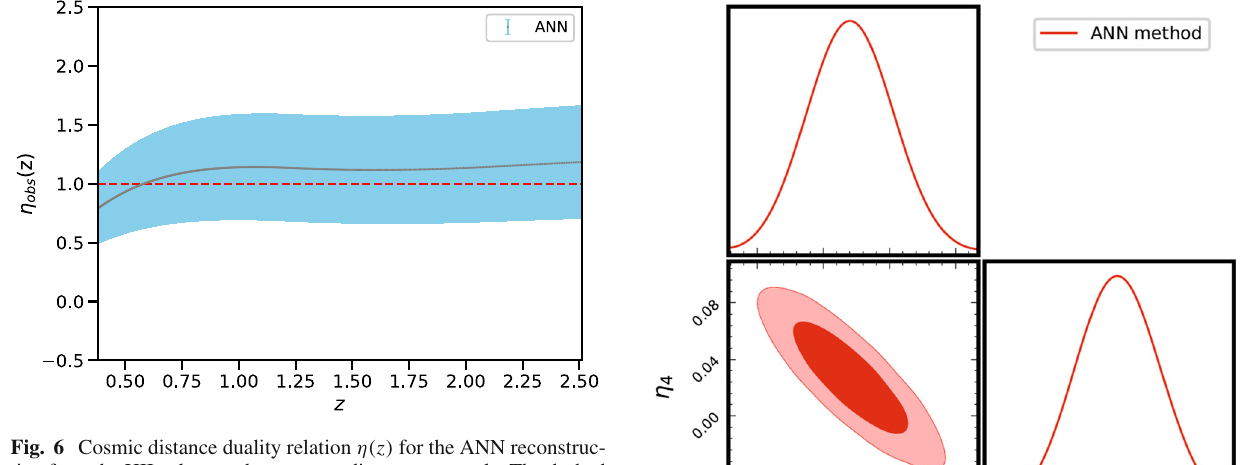
Fig. 6 Cosmic distance duality relation η( z ) for the ANN reconstruc- tion from the HII galaxy and compact radio quasar sample. The dashed line at unity is η( z ) = 1, the solid line is the ANN fit, and the shaded region is the 1 σ ANN errors